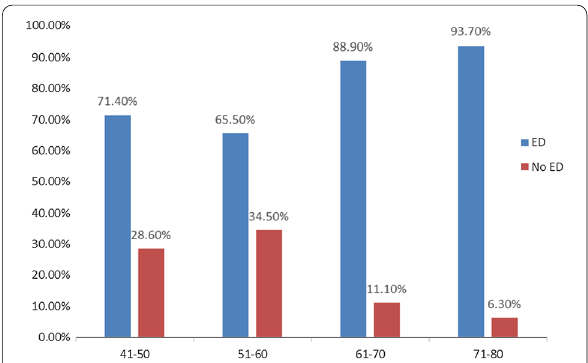
Fig. 3 Age distribution of ED. X 2